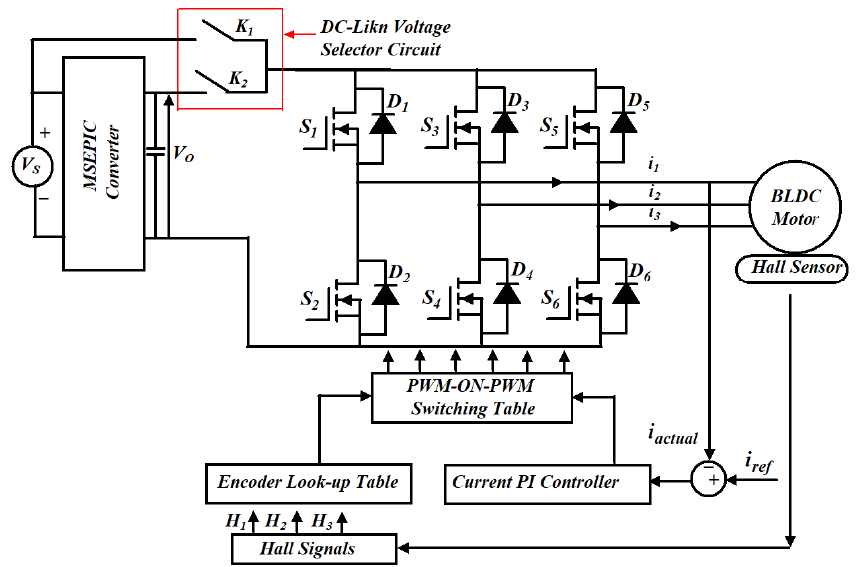
Figure 9. Framework for MATLAB/Simulink and experimental setup of the proposed control strategy for the BLDCM drive.